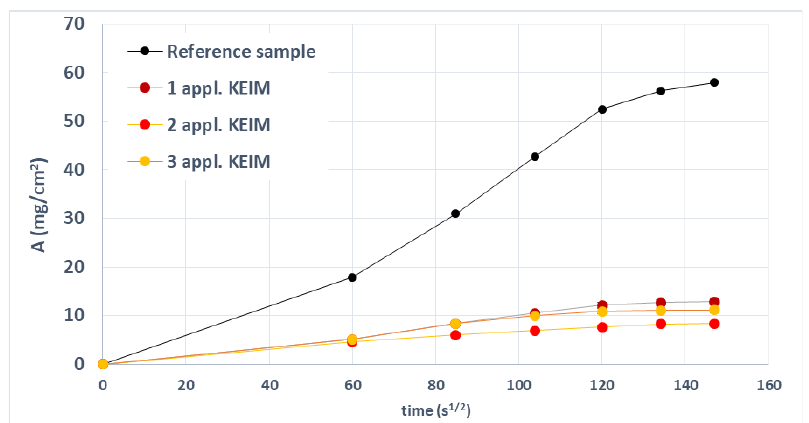
Figure 5. Absorbance over time detected on samples uncoated and coated with AG09W.